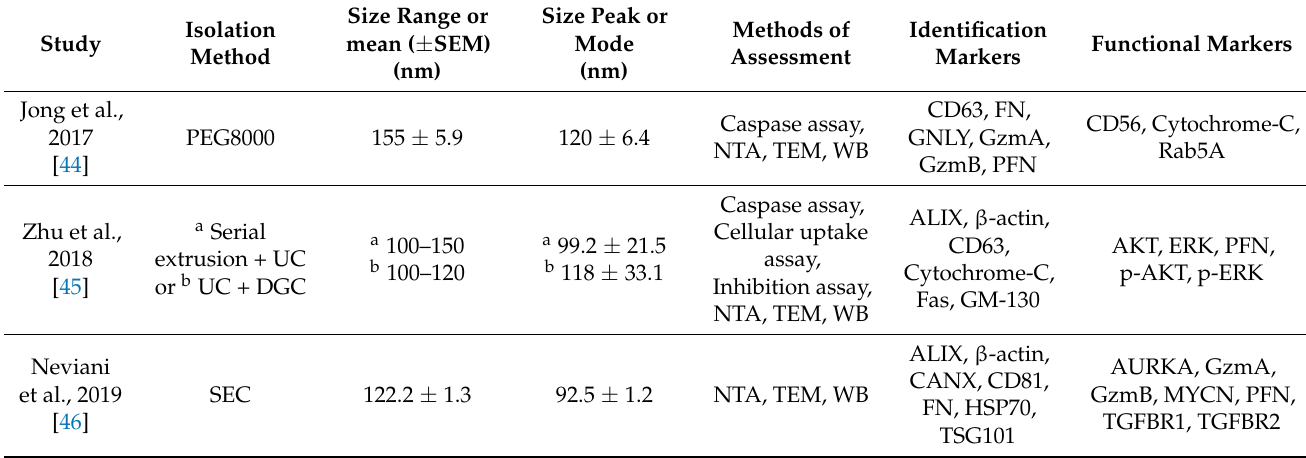
Table 3. Method of isolation, characterization and functional analysis of